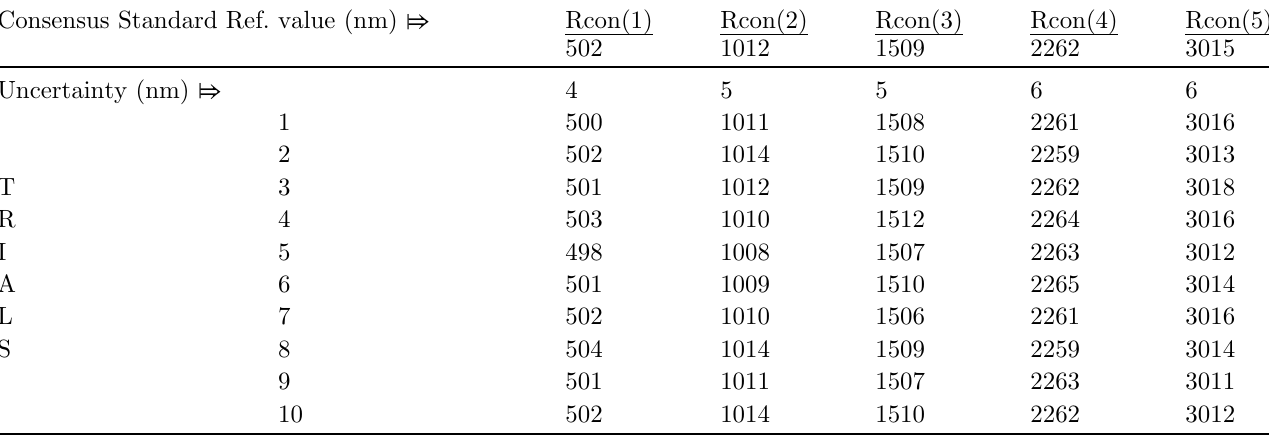
Table 5. Example 4. FAC-1; measurement system A; Linearity study.